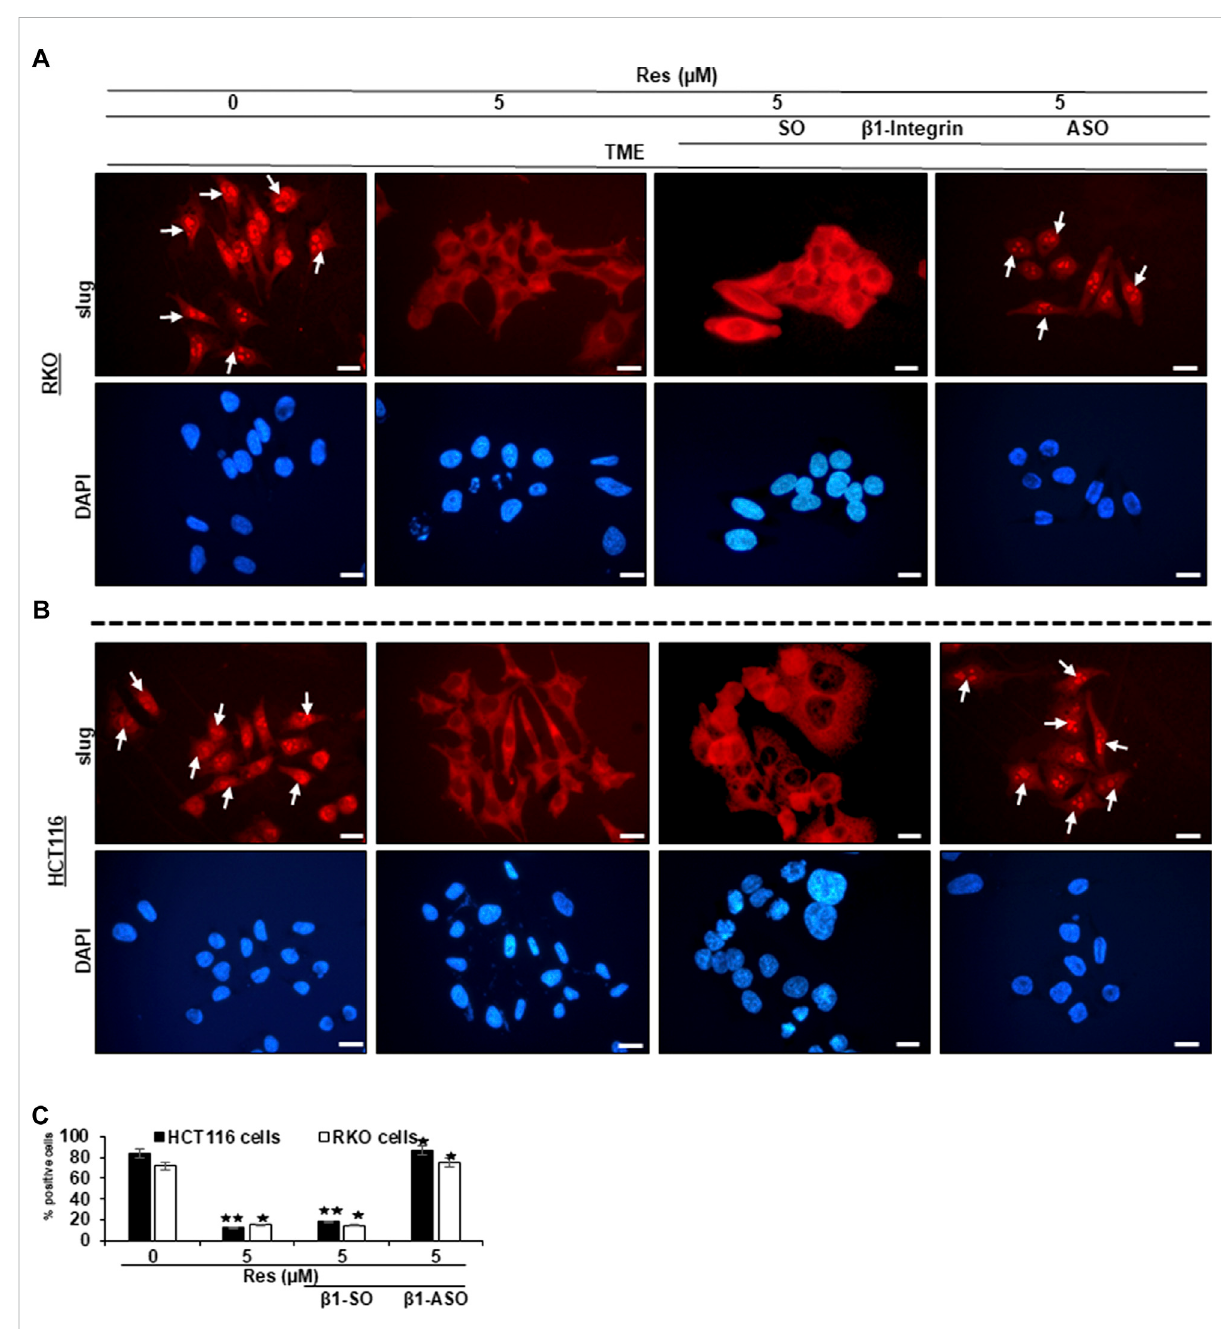
FIGURE 3 Impact of resveratrol or/and ASO against β 1-integrin on TME-mediated EMT-linked transcription factor slug activation in CRC cells. RKO (A,C) and HCT116 (B,C) cells in TME on coverslips, left untreated or treated with resveratrol (5 µM) or resveratrol-treated (5 µM) with addition of β 1-SO (0.5 µM) or knocked down with β 1-ASO (0.5 µM). CRC cells were immunolabeled with anti-slug (red) and DAPI-stained (blue). White arrows = slug positive CRC cells. Microscope: Leica DM 2000. Magni fi cation ×600; scale bar = 30 µm. Statistics: * p < 0.05 and ** p < 0.01, in relation to TME